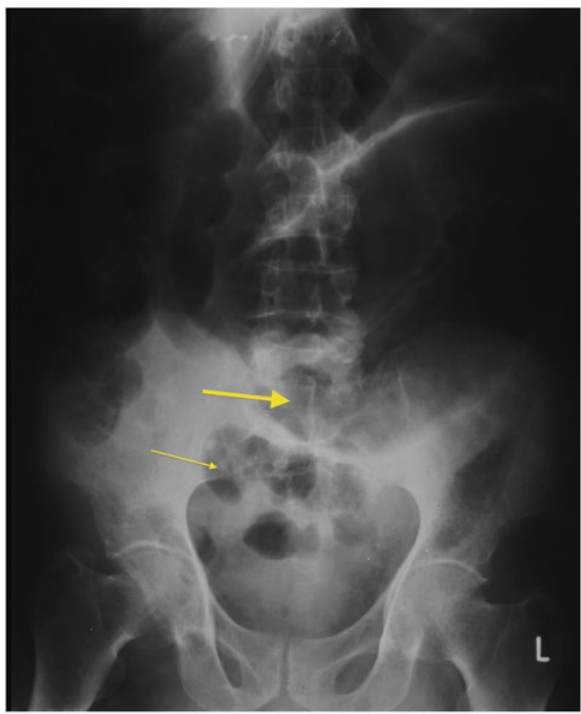
Figure 3b: Plain radiograph of surgically-confirmed ileosigmoid knot showing dilated sigmoid colon with the apex in the left upper quadrant and the point of convergence overlying the right iliac fossa (thick arrow) with dilated small bowel loops in the pelvis (thin